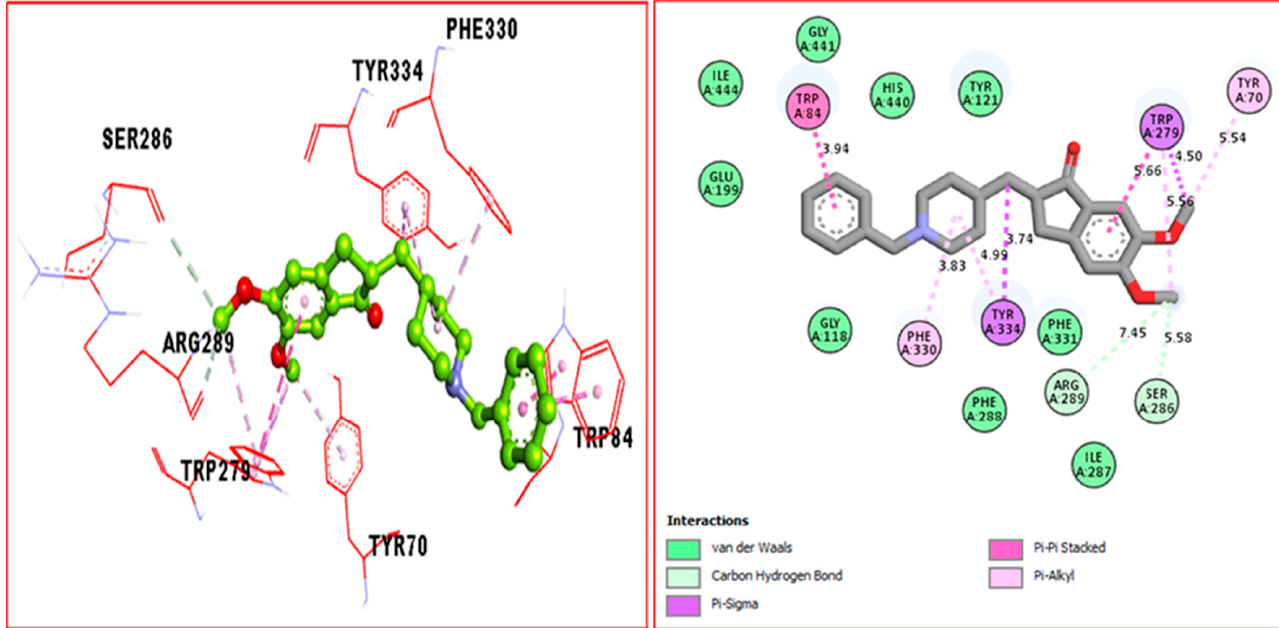
Figure 13. Representation of the PLI profile for donepezil against AChE.